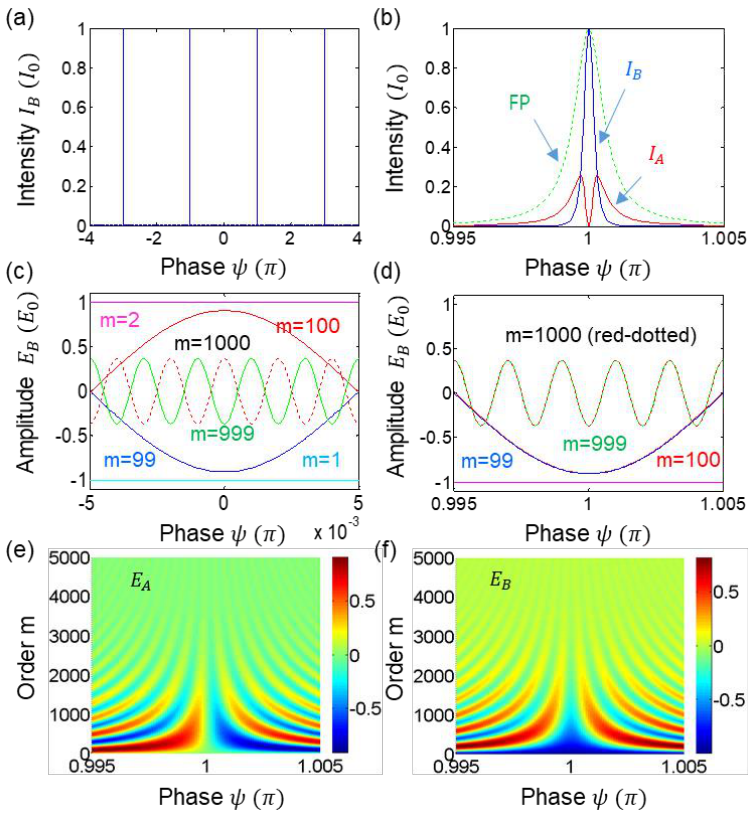
Figure 2. Numerical calculations for Equation (2). ( a , b ) Output intensities. ( c – f ) Output amplitudes. Amplitudes and intensities are normalized. Reflection coefficient is set at r = 0.999. The ring laser gain is not included. FP: Fabry–Perot